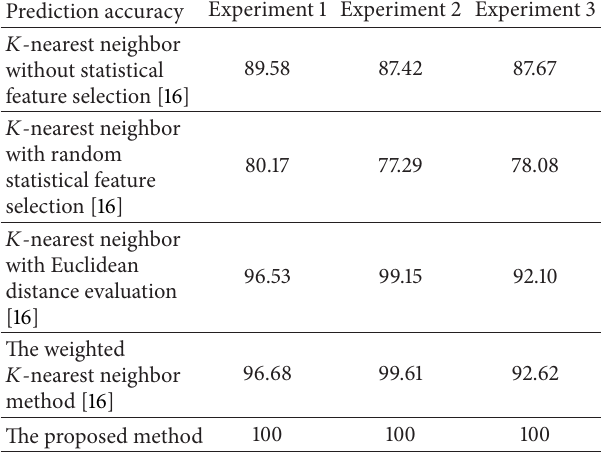
Table 3: Comparisons of the prediction accuracies obtained by using the proposed method and the four methods reported in [16] (unit: %). (Note: methods 1 to 4 are used to distinguish three gear health conditions, while the proposed method is used to classify five gear health